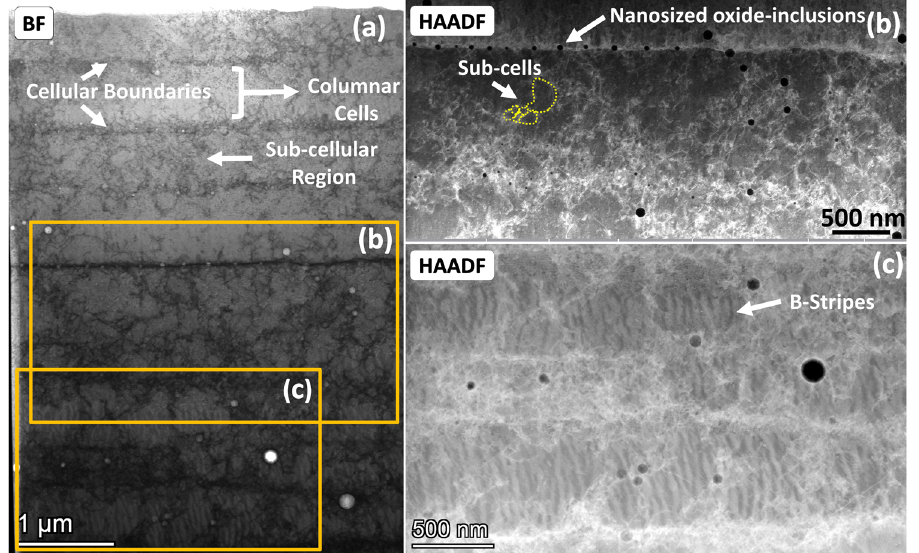
Fig. 2 STEM micrographs of SLM-316L. a BF image depicting the columnar cellular structure with cells and cell boundaries. b HAADF image showing the nanosized oxide-inclusions and sub-cells. c HAADF image of the B-stripe